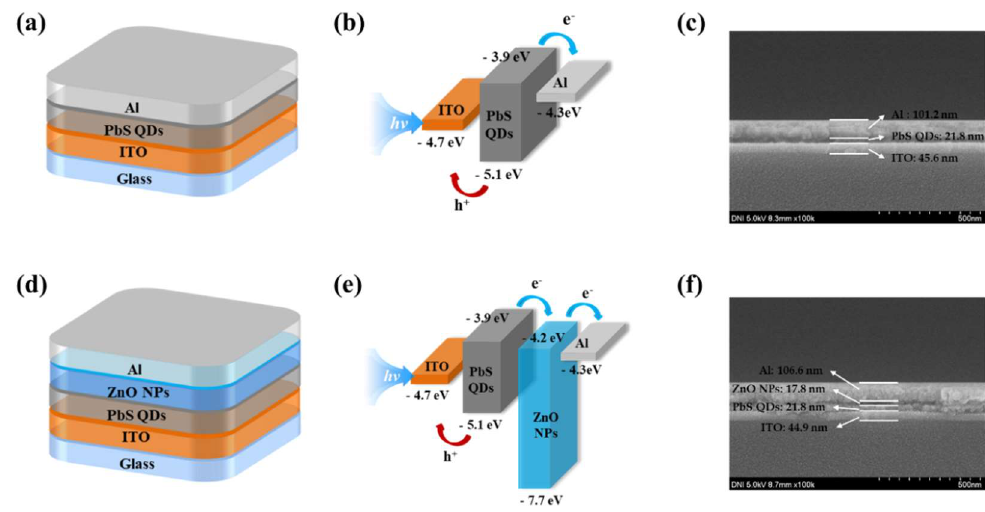
Figure 1. ( a ) Schematic device structure, ( b ) energy band diagram and ( c ) FE-SEM image of the PbS SWIR sensor without ZnO NPs, ( d ) schematic representation of the device structure, ( e ) energy band diagram and ( f ) FE-SEM image of the PbS SWIR sensor with ZnO NPs.